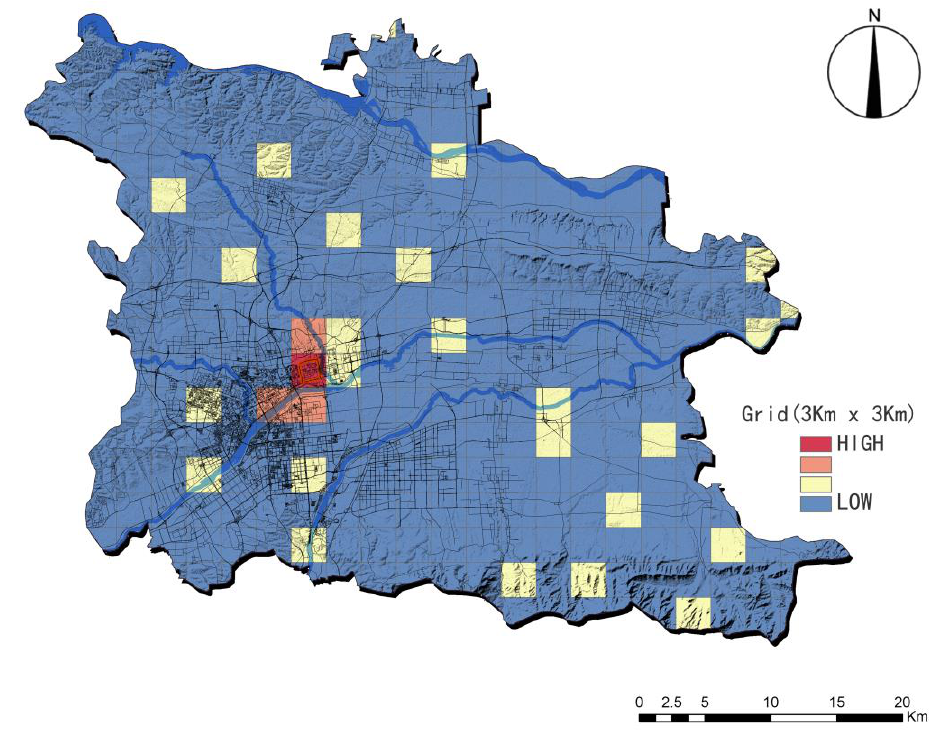
Figure 15. Statistical map of the distribution of historical buildings in Luoyang City by fishnet grid.